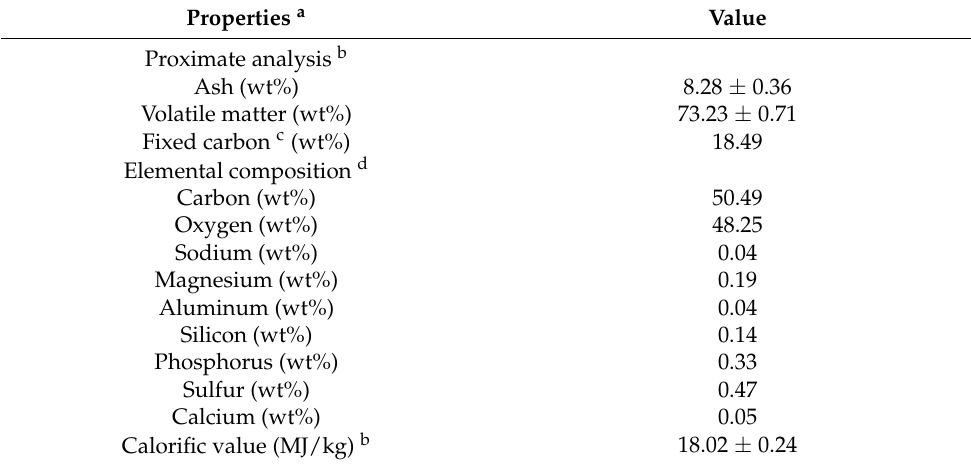
Table 1. Thermochemical properties of pineapple peel (PP).